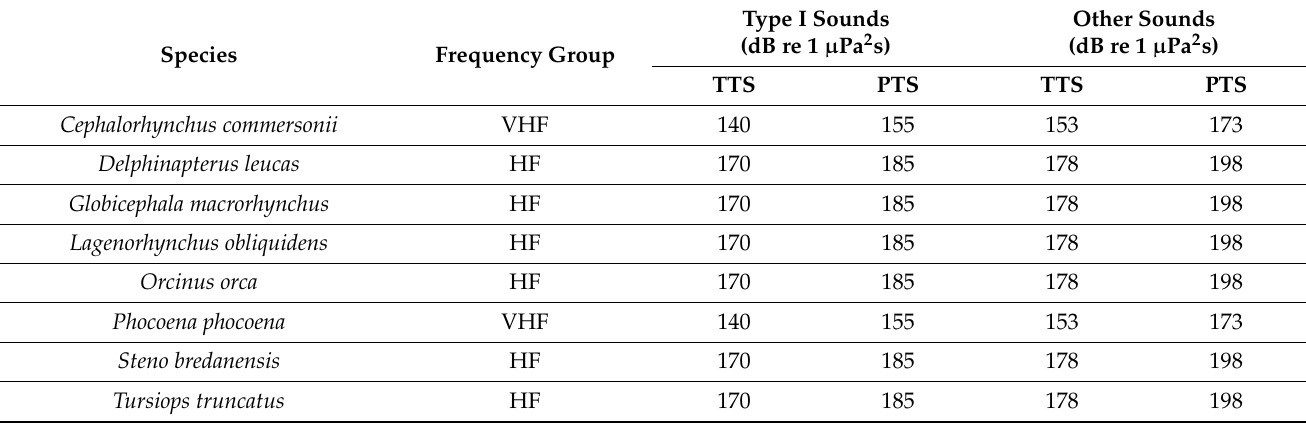
Table 1. Exposure limits of cetacean species commonly exhibited under managed-care, including high-frequency (HF) and very-high-frequency (VHF) groups. Proposed sound exposure limits are weighted auditory frequency, expressed as dB re 1 µ Pa 2 s, and adapted from Southall et al. (2019). Additional species thresholds and auditory weighting information is available in main